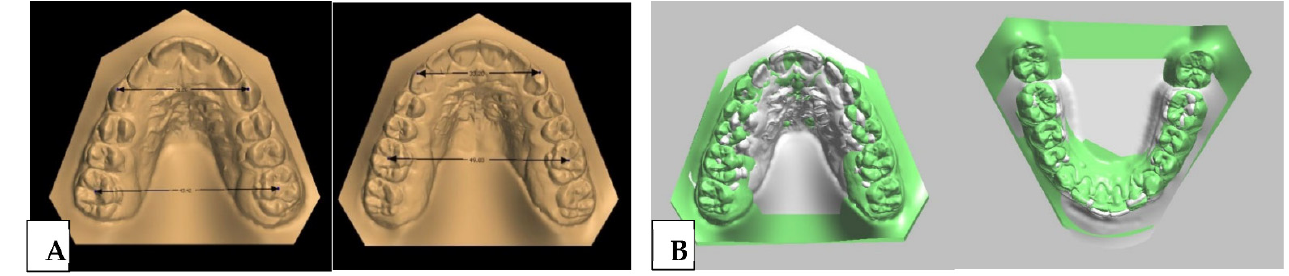
Figure 14. ( A ) Comparison and ( B ) superimposition of digital maxillary models before and after treatment.